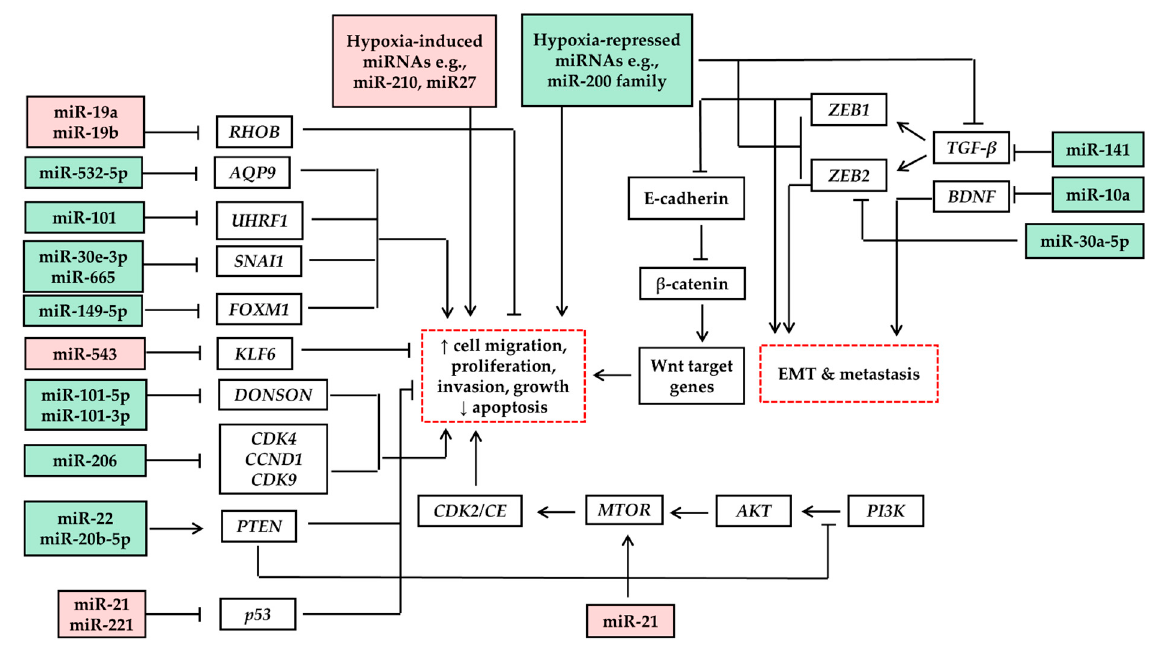
Figure 1. miRNAs up-regulated (red-colored) and down-regulated (green-colored) in renal-cell carcinoma and their target genes and regulated pathways. EMT: Epithelial-mesenchymal transition, TGF- β : transforming growth factor-beta, BDNF; Brain-derived neurotrophic factor, ZEB: Zinc Finger E-Box Binding Homeobox, PI3K: phosphoinositide 3-kinase, AKT: AKT Serine/Threonine Kinase 3, MTOR: mammalian target of rapamycin, CDK: cyclin-dependent kinase, RHOB: Ras